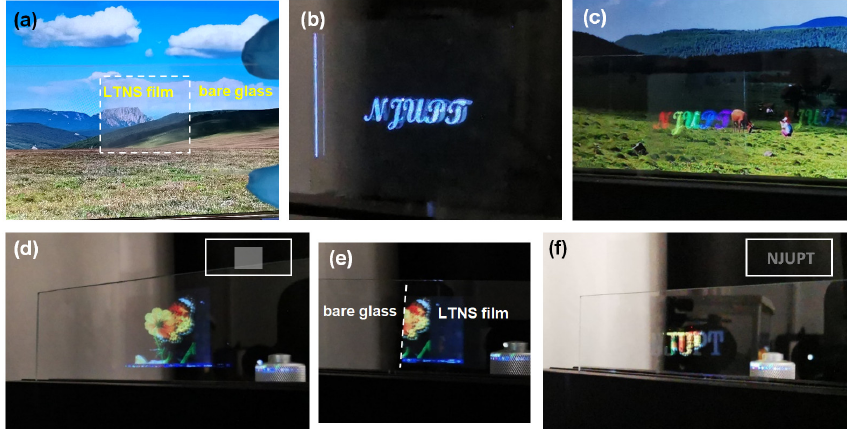
Figure 10. ( a ) Photograph of the laser-printed LTNS film on a glass slide. ( b – e ) Letters and images were projected on to the LTNS film. ( f ) The image was projected onto the letters NJUPT.